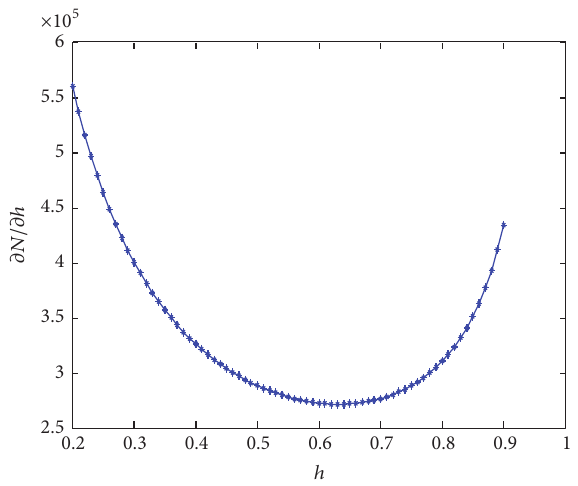
Figure 1: The relation between market size and supervision proba- bility with 𝑁 = 100000 ; ℎ = (0.2,0.9) .